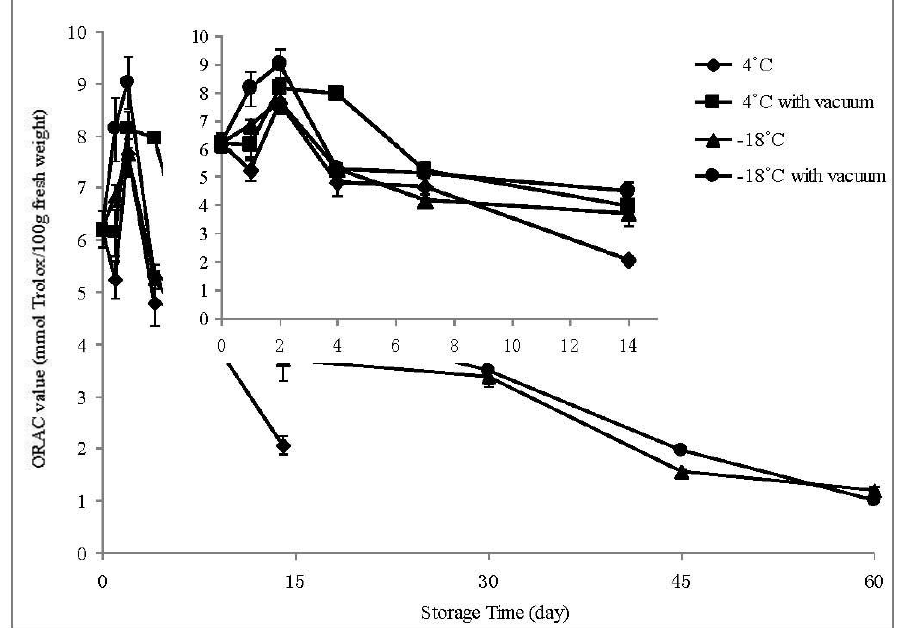
Figure 2. The temporal trend on oxygen radical absorbance capacity of Benihope strawberry samples stored at 4 °C and −18 °C with or without vacuum. Bars represent mean values ± SD, n = 3 separate experiments. The upper right is enlargement graph within 14